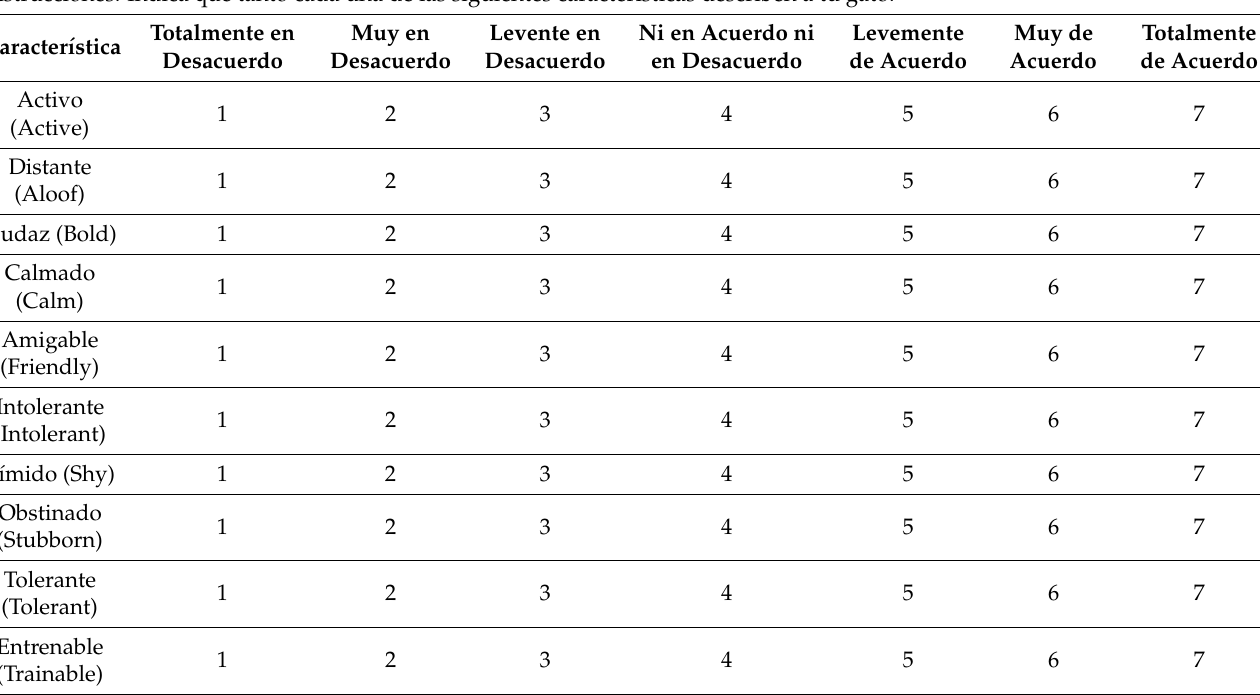
Table A2. Questionnaire about the Personality Traits of Cats (Spanish